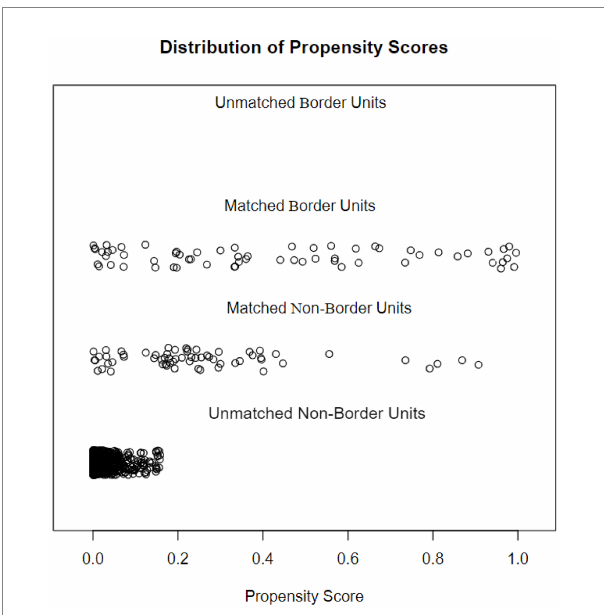
FIGURE 2 Distribution of propensity